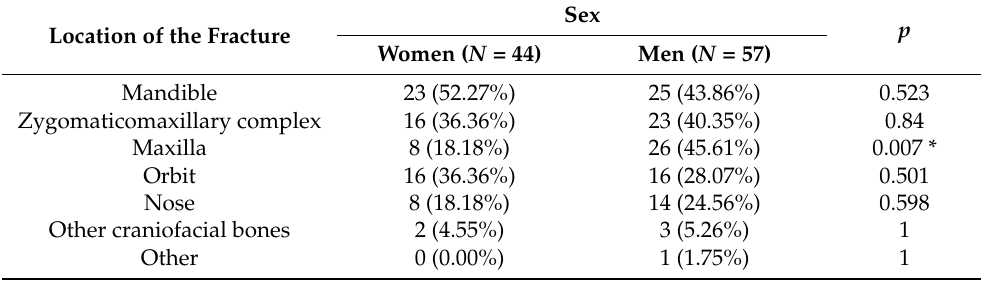
Table 8. Location of the fracture and the patients’ sex.